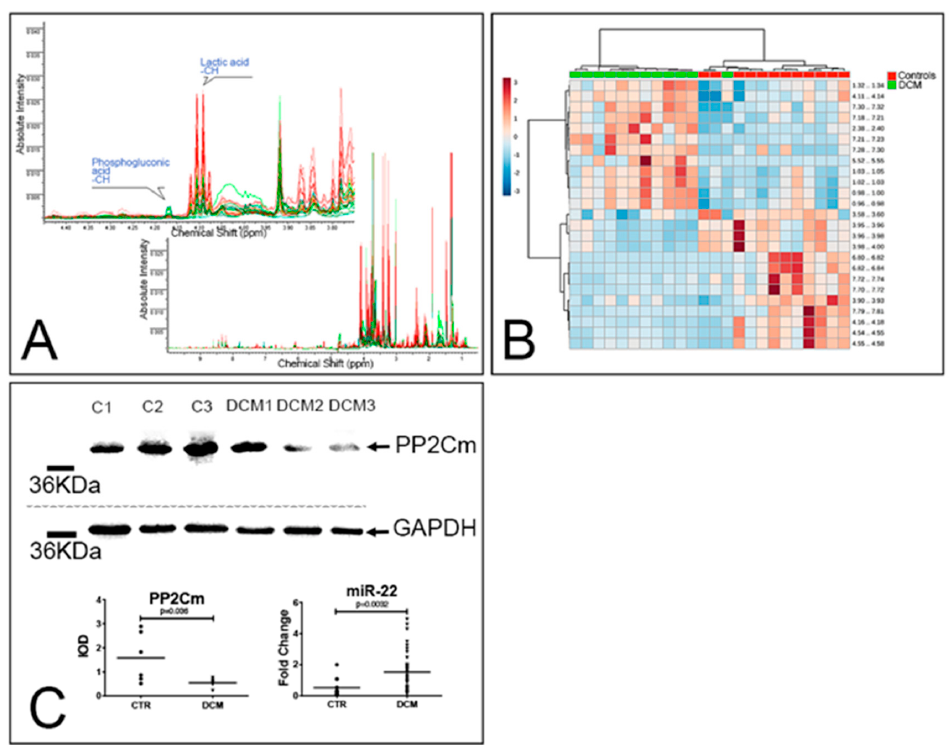
Figure 4. DCM is associated with alterations of amino acid metabolism. ( A , B ) Metabolomic analysis. 1D NMR spectra of 12 control (green lines) and 12 DCM hearts (red lines). The full spectra are shown in the bottom panel, while the top panel shows the 3.75–4.45 ppm region and the peaks assigned to lactic acid and 6-phosphogluconic acid ( A ). Heatmap summarizing the results of the hierarchical clustering analysis generated employing the top 25 features ranked by t tests. Each colored cell on the map corresponds to a concentration value in the data table, with samples in columns and features/compounds in rows ( B ). ( C ) WB and real-time PCR analyses. Representative WB of whole-protein extracts of 3 control hearts and 3 DCM explanted hearts. Blotted proteins were incubated with antibodies against PP2Cm and GAPDH. Results of the densitometric analyses ( n = 6 controls and 6 DCM) are reported in the bottom-left panel; a Mann–Whitney test was employed. The bottom-right panel summarizes the results of the RT-PCR analysis of miR-22 expression in control ( n = 12) and DCM ( n = 37) hearts; a Mann–Whitney test was employed. Fold change was computed using miR-92a as a housekeeping gene.